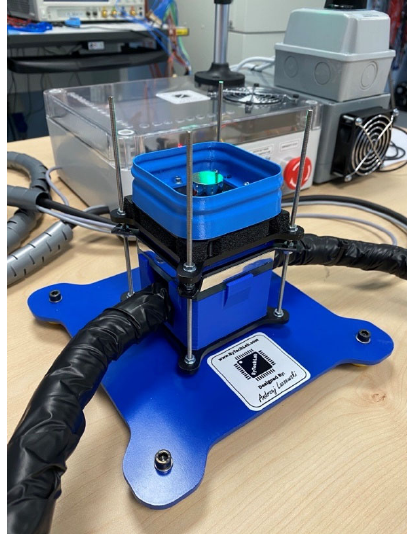
Figure 7. Chip ‐ on board mounting